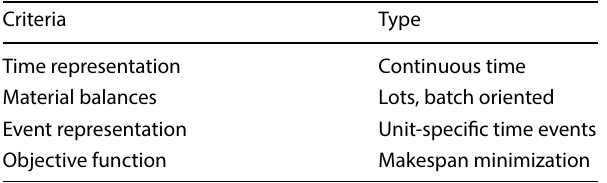
Table 1 Classification of the scheduling model (based on [7]) Criteria